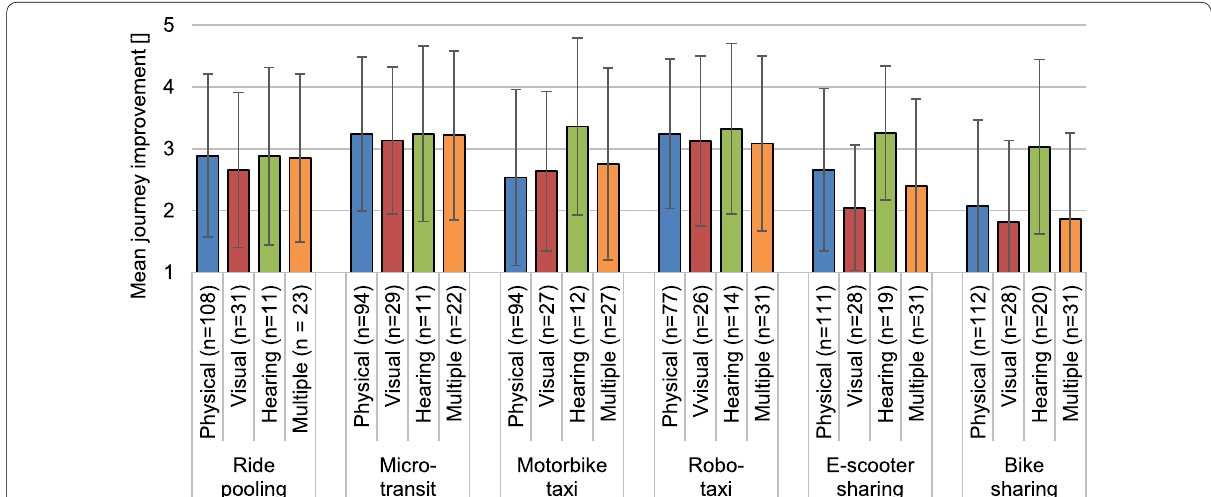
Fig. 3 Projected overall journey improvement using the shared mobility services by type of disability (mean score with SD with 1 improvement, 5 very large improvement; note: the n in each column corresponds to approximately a third of the total N per type of disability. The = different numbers of responses result from the randomized presentation of two out of six shared mobility